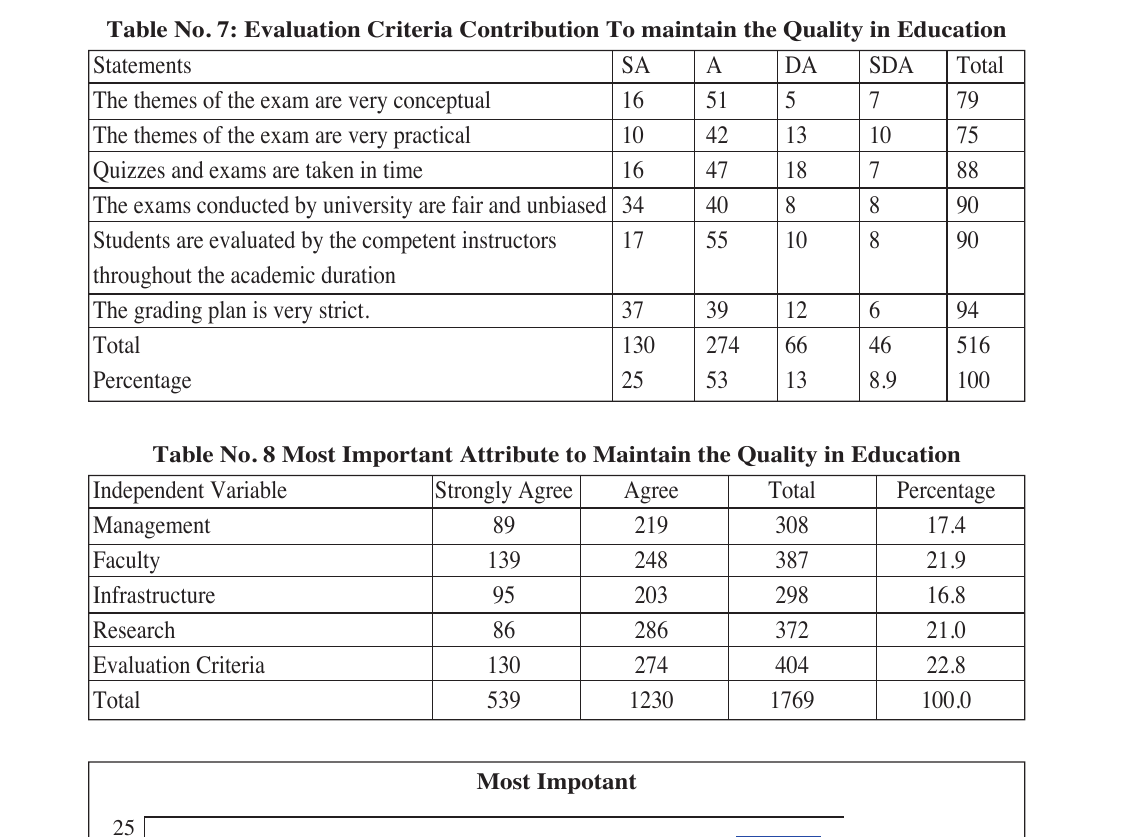
Table No. 7: Evaluation Criteria Contribution To maintain the Quality in Education